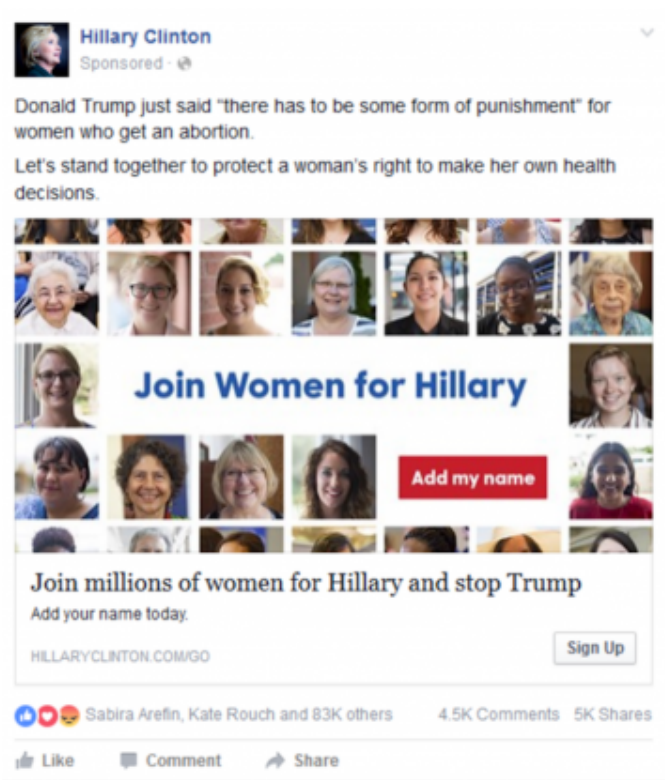
Figure 3: Hillary Clinton Facebook